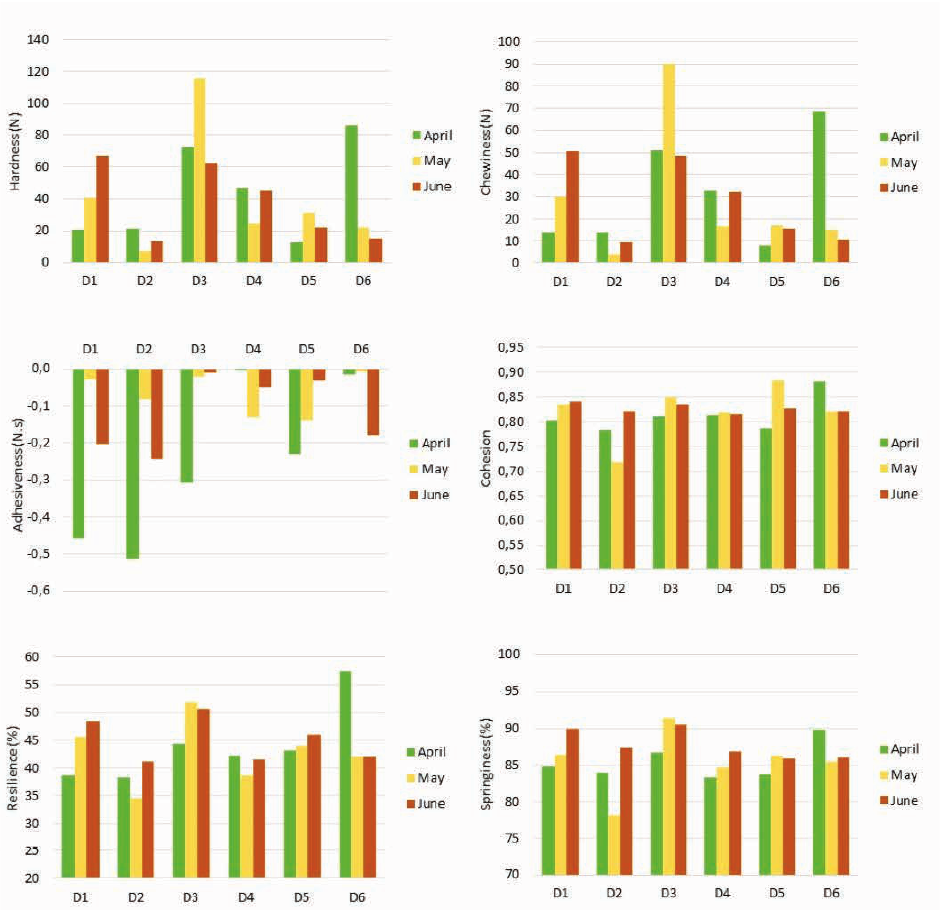
Figure 4: Variation of textural properties in the cheeses as a whole from April to June, obtained by the compression